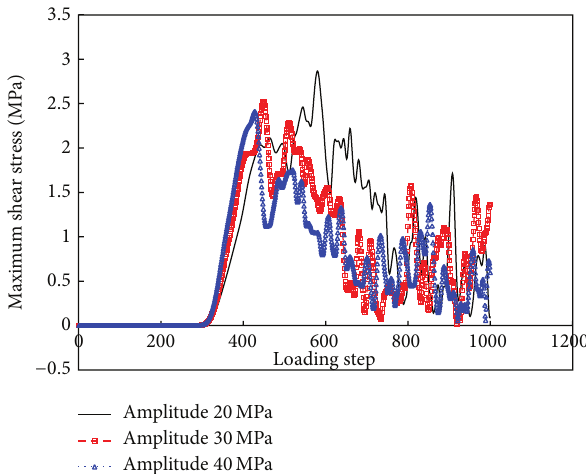
Figure 7: Variation law of maximum shear stress on numerical sample unit.